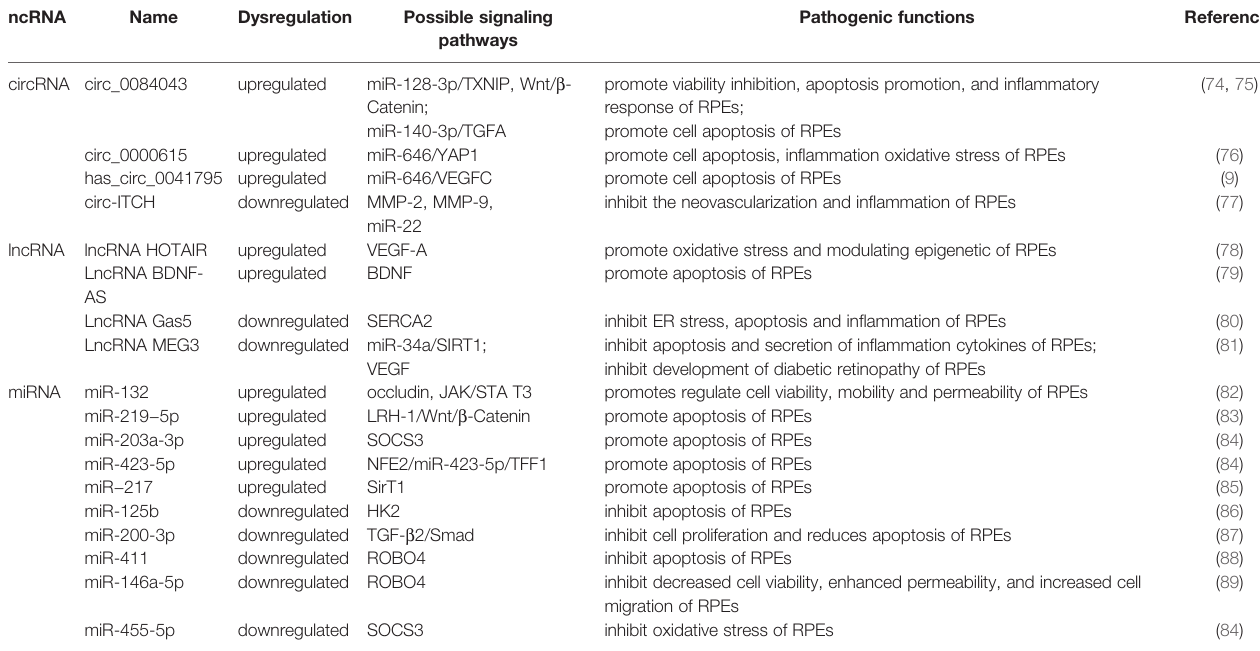
TABLE 2 | The role of miRNA, lncRNA and circRNA in DR and their mechanisms through retinal pigment epithelial cell and targets.